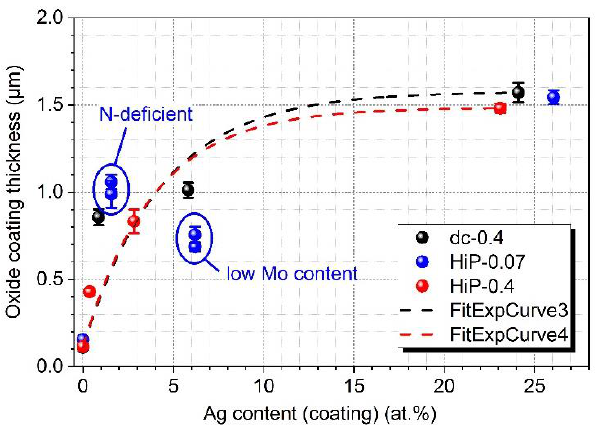
Figure 16. Oxide coating thickness vs. Ag content of MoN-Ag coated steel samples from tribological tests at 450 °C.